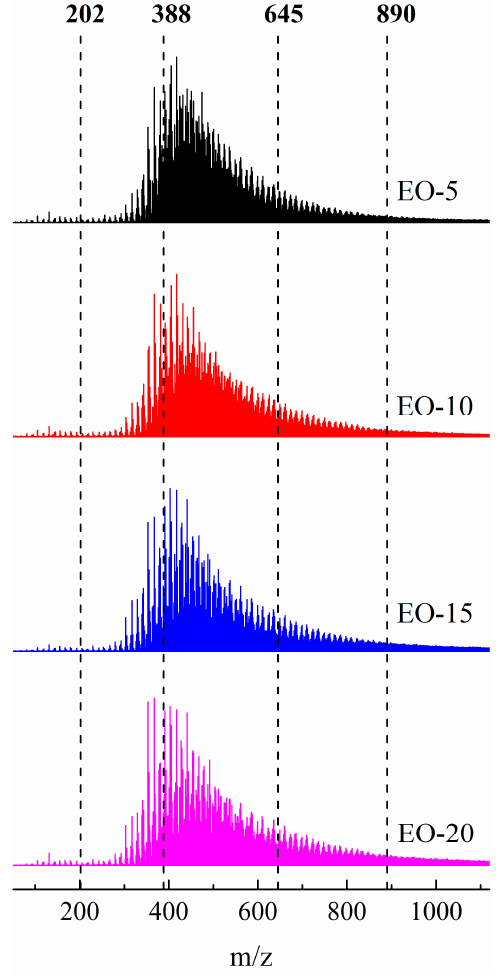
Figure 5. The molecular weight distribution of isotropic pitch precursors by MALDI TOF-MS.